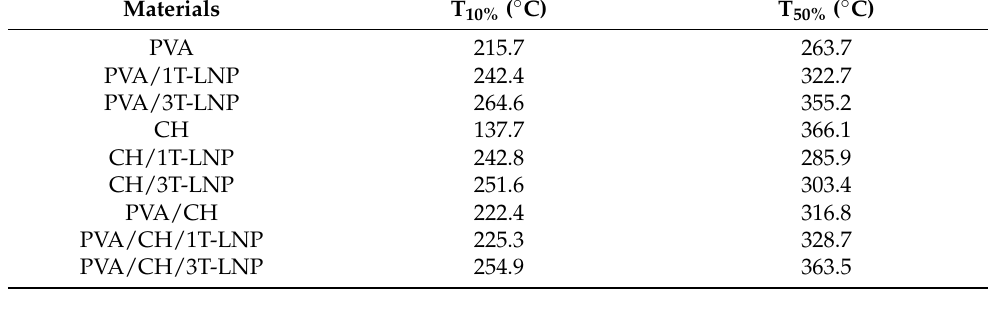
Table 7. Detailed TG parameters for PVA, CH and LNP composited films.